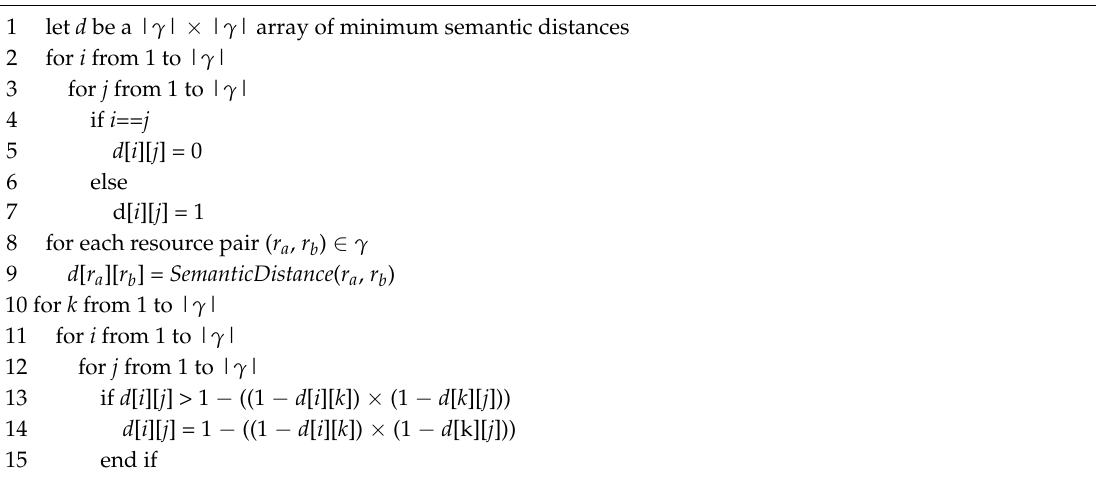
Algorithm 1: The semantic distance spreading